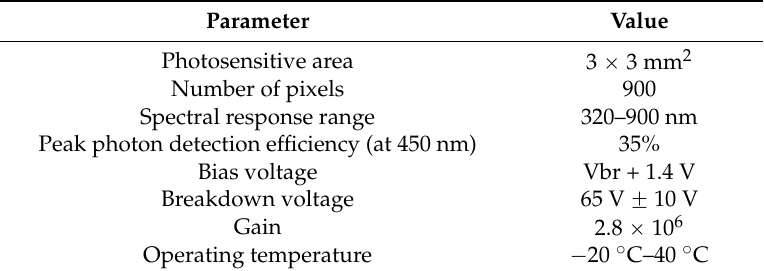
Table 1. Specifications of Si photomultiplier (SiPM) used in this study.